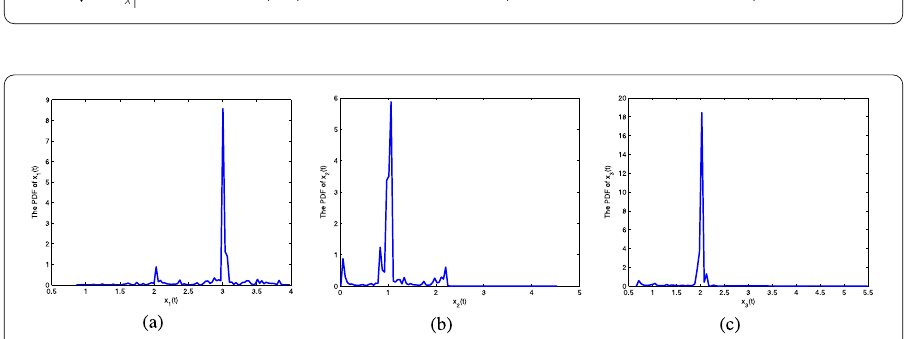
Figure 1 The sample paths of three-species densities . (a) The sample paths of x i ( t ), i = 1,2,3. The parameter values used in Example 5.1; (b) Under the control ˆ u 1 = (– sample paths of x i ( t ), i = 1,2,3. The parameter values used in Example 5.2; (c) Under the ˆ